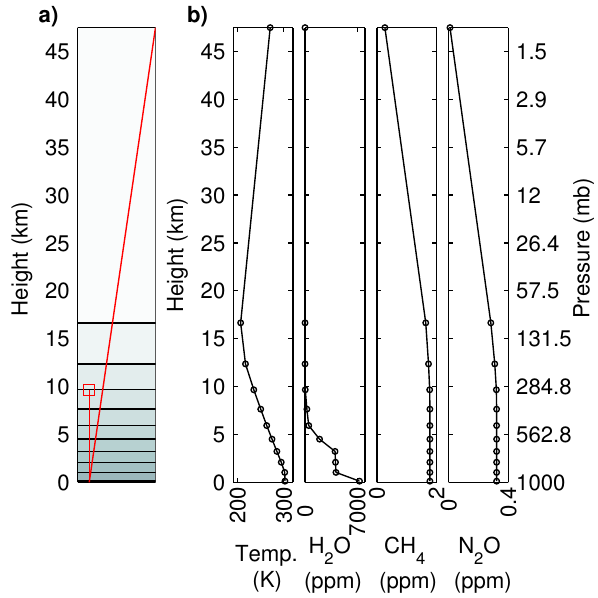
Fig. 2. (a) 10 atmospheric layers were used for retrievals (layer 1 at the top). For the COP scene, the aircraft was placed between layer 3 and 4 (red square). The slant and vertical light paths (red lines) were used to scale optical densities appropriately. (b) Profiles of temperature and VMR of H 2 O, CH 4 , and N 2 O for the boundaries of each layer (black circles).